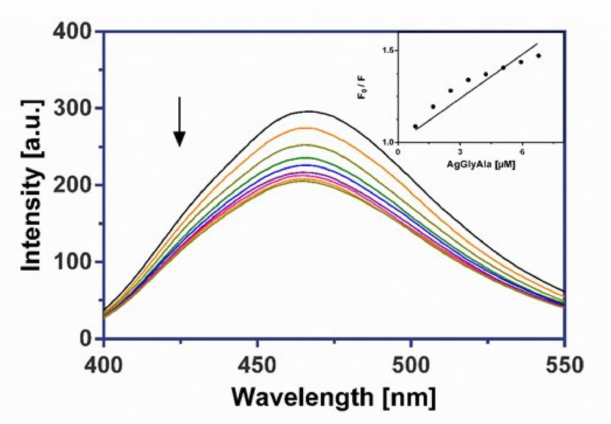
Figure 9. The emission spectra of CT DNA–HO in the presence of AgGlyAsp. Arrow shows the intensity changes upon increasing the complex concentration. Inset: the corresponding Stern– Volmer plot.